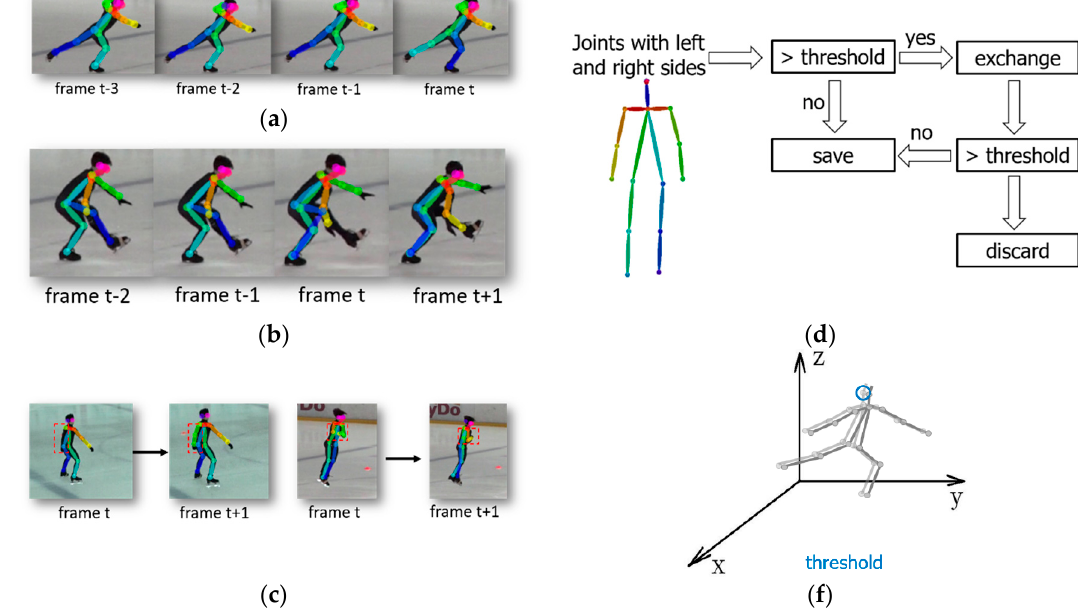
Figure 5. In order to get good reconstruction results, the system should first correct the errors as much as possible at the 2D level. ( a ) Left–right inversion; ( b ) wrong identification; ( c ) sudden appearance and disappearance; ( d ) the flowchart of proposal 1; ( e )